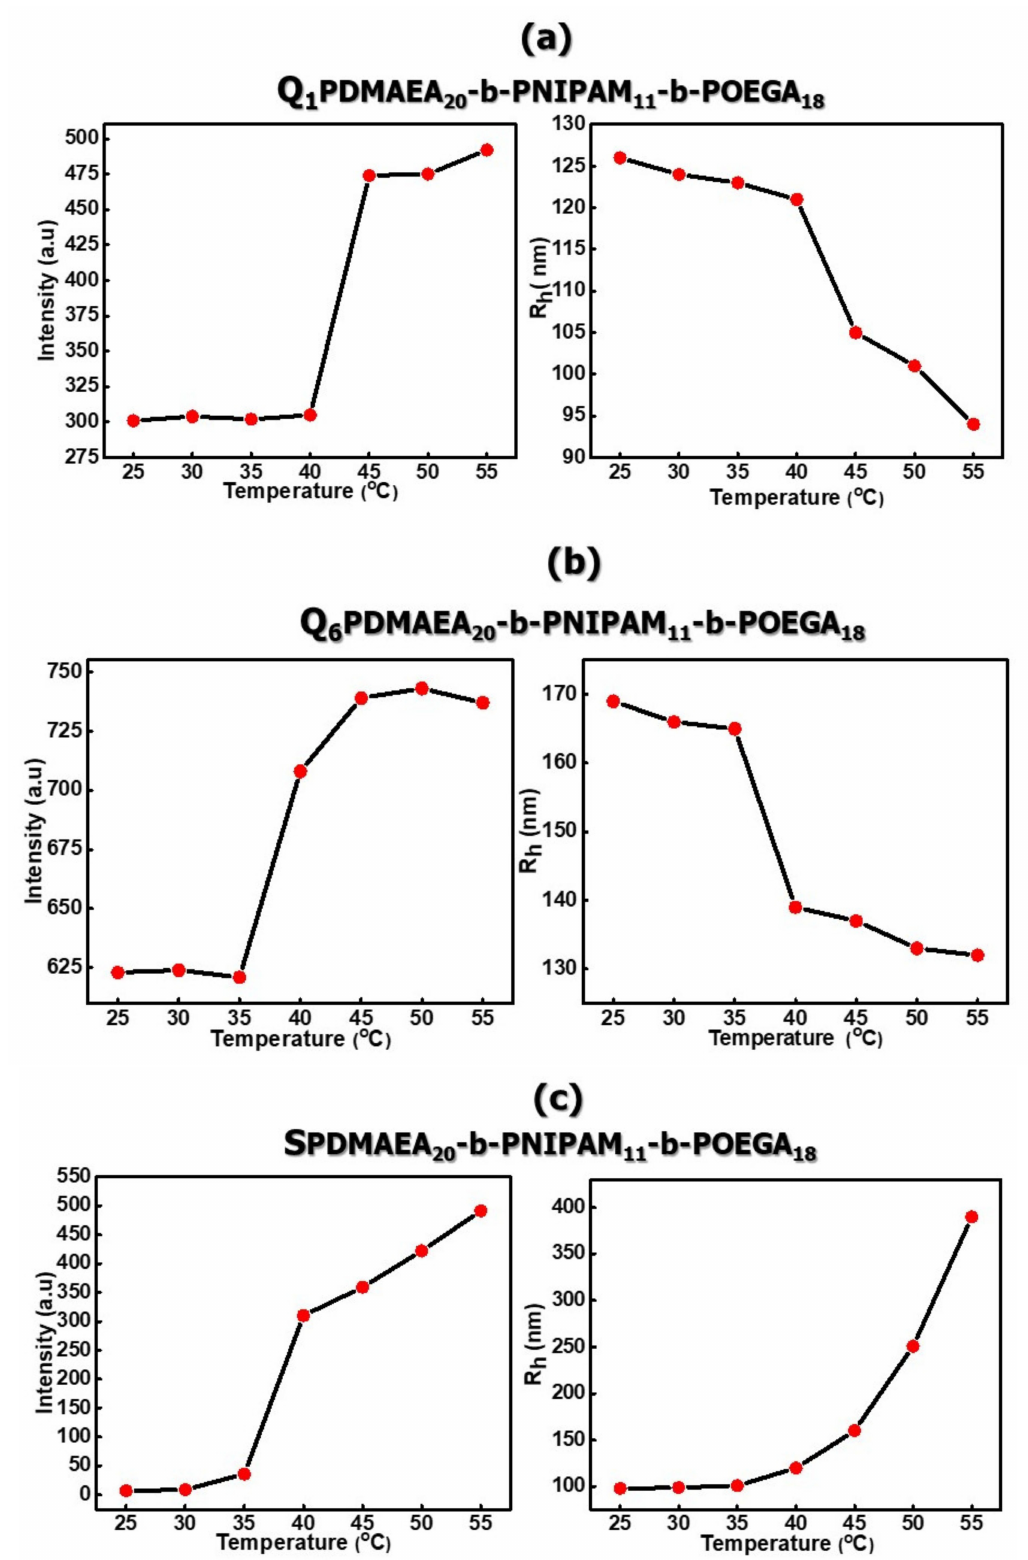
Figure 6. The dependence of scattered intensity and hydrodynamic radius on temperature for Q 1 PDMAEA 20 -b-PNIPAM 11 -b-POEGA 18 ( a ), Q 6 PDMAEA-b-PNIPAM 11 -b-POEGA 18 ( b ), and SPDMAEA 20 -b-PNIPAM 11 -b-POEGA 18 ( c ) in aqueous solutions at pH = 7 and c = 1 × 10 − 3 g / mL. (measurements obtained at a 90 ◦ angle). The hydrodynamic radius of SPDMAEA 20 -b-PNIPAM 11 -b-POEGA 18 is the average values extracted from the cumulants